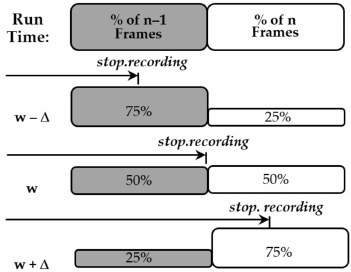
Figure 15. Histograms showing the effect of incrementing the wait/stop time.